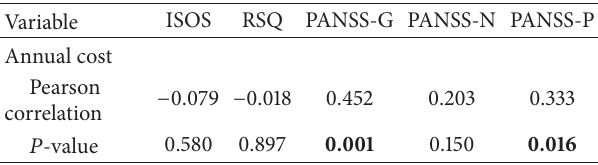
Table 2: Pearson correlation between annual cost and recovery style/PANSS subscale. We did not find any significant correlation with recovery style scales. We instead highlighted a positive correla- tion between annual cost and PANSS-G and PANSS-P subscales.